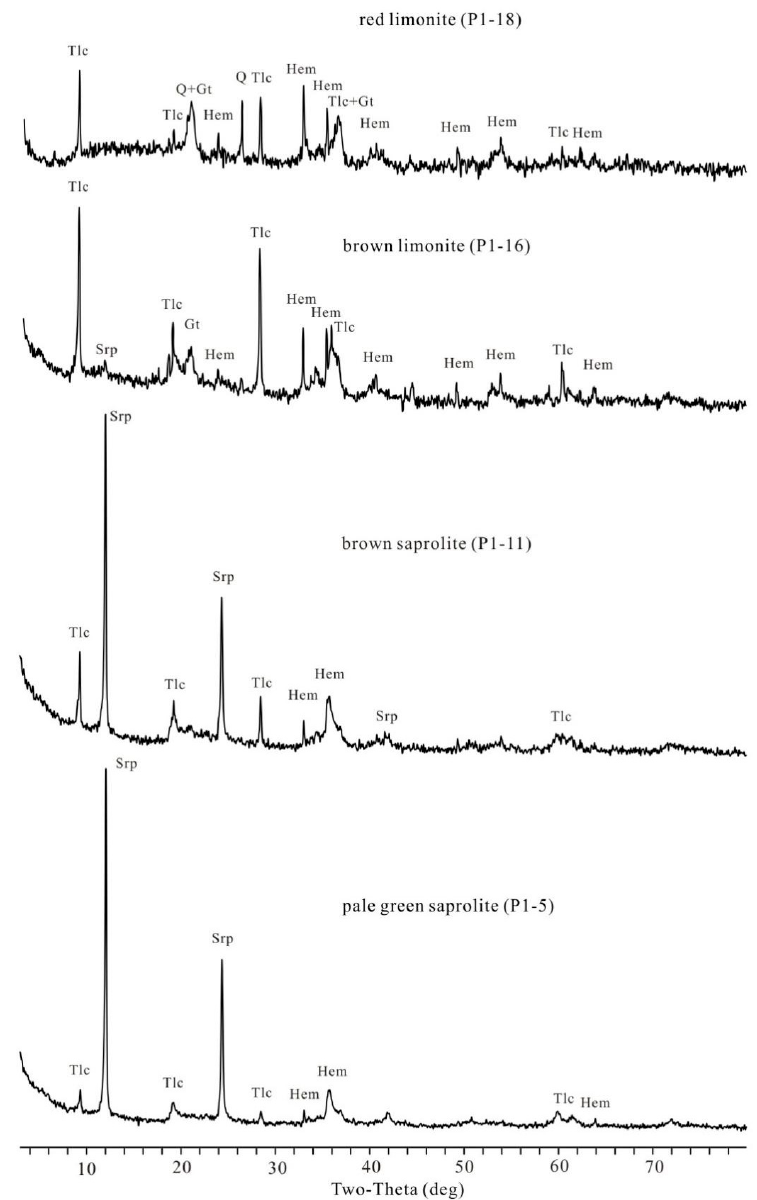
Figure 6. X-ray diffraction (XRD) patterns of the samples from different horizons in the Ni laterite profile. Abbreviations: Go, goethite; Hem, hematite; Srp, serpentine; Q, quartz; Px, pyroxene; Tlc, talc.